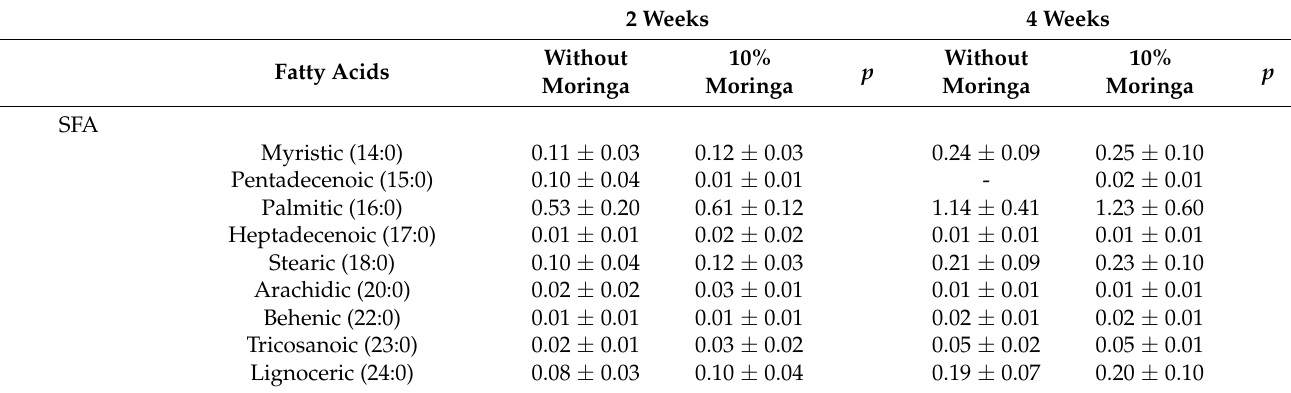
Table 2. Fatty acid composition of gilthead seabream fed with and without supplemented diet with Moringa oleifera (MO) 10% for 2 and 4 weeks. All determinations were performed in triplicate and values shown are mean ± standard deviation. 2 Weeks 4 Weeks Without 10% Without 10% Fatty Acids p